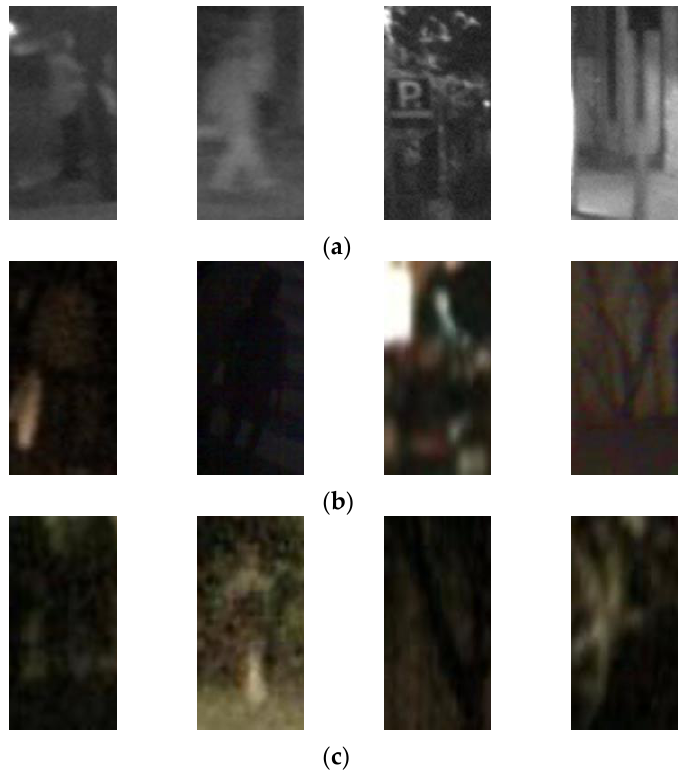
Figure 7. Examples of FN and FP errors in cases using original images of ( a ) CVC-14 database; ( b ) DNHD-DB1; and ( c ) KAIST database. In ( a – c ), the left two images show the FN cases, whereas the right two images represent the FP cases.